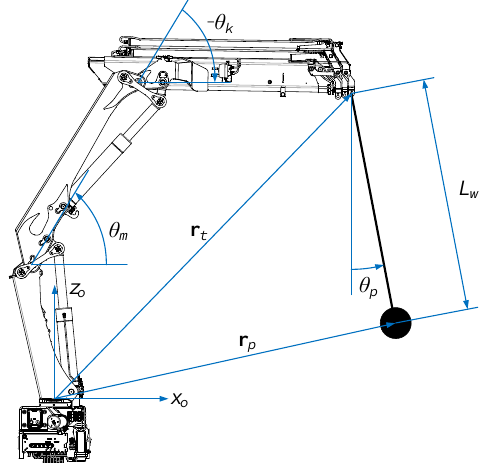
Figure 26. Illustration of the HMF crane with hanging